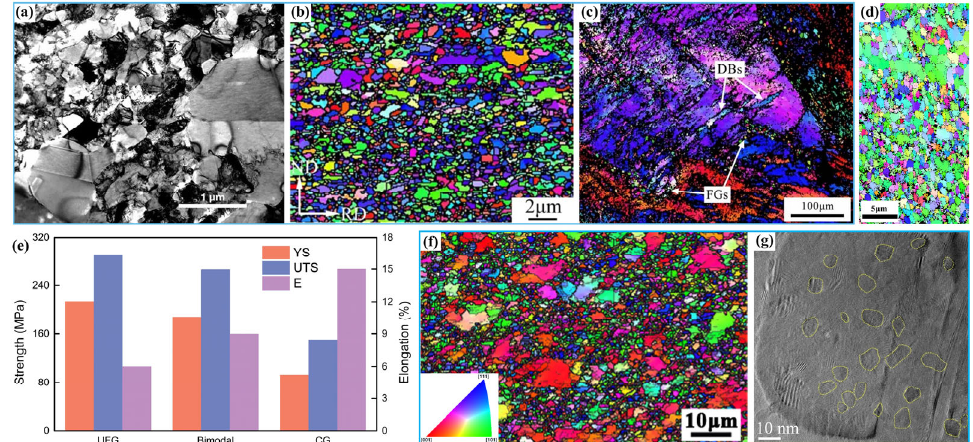
Figure 1. ( a ) Transmission electron microscopy (TEM) image of bimodal nanostructure Cu [18]; ( b ) electron backscatter diffraction (EBSD) inverse pole figure (IPF) of bimodal-structured steel [20]; ( c ) EBSD IPF of Al–Mg alloy after high strain rate rolling (DBs and FGs refer to deformation bands and fine grains, respectively) [19]; ( d ) EBSD IPF of a bimodal Al6063 alloy [41]; ( e ) the mechanical properties of ultrafine-grained structure, bimodal structure, and coarse-grained structure Al6063 alloys, “E” represents the strain to fracture; ( f ) EBSD IPF of a bimodal structure Ni (the inset shows the standard IPF color code) [42]; ( g ) TEM image of an ultrafine-grained structure in which nanoscale Ni domains are distributed (the area circled in yellow refer to nanoscale Ni domains)